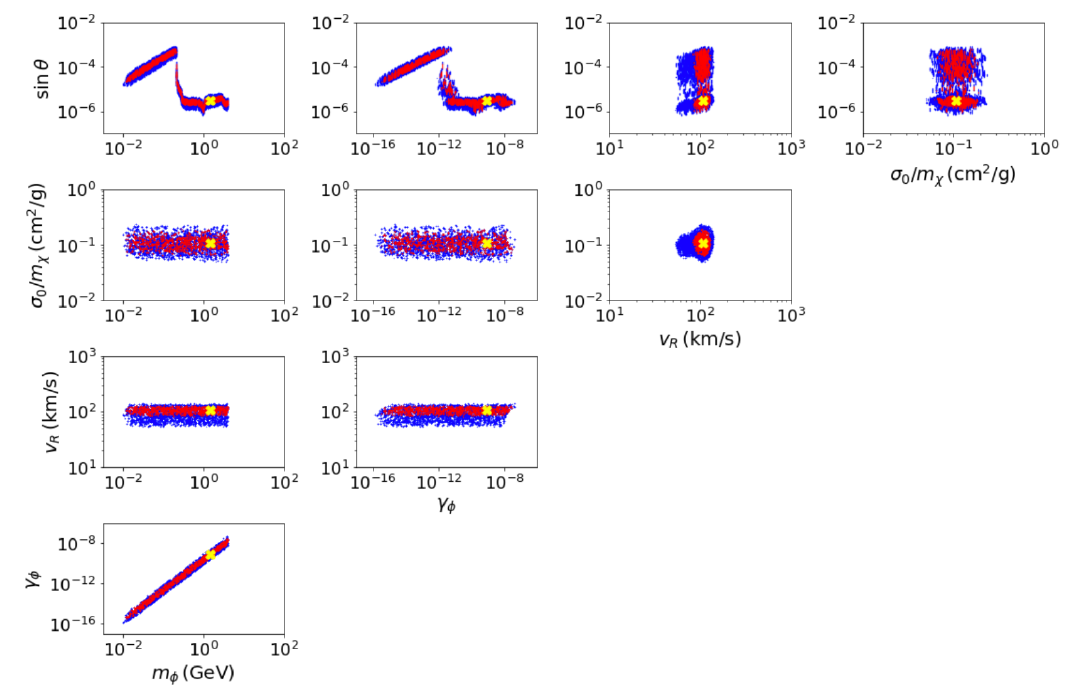
Figure 4 . The model parameter region favored by the self-scattering condition, the relic abundance condition, and the CMB constraints is shown at 1 σ (red points) and 2 σ (blue points) levels with the yellow crossing mark being the parameter set giving the maximum likelihood